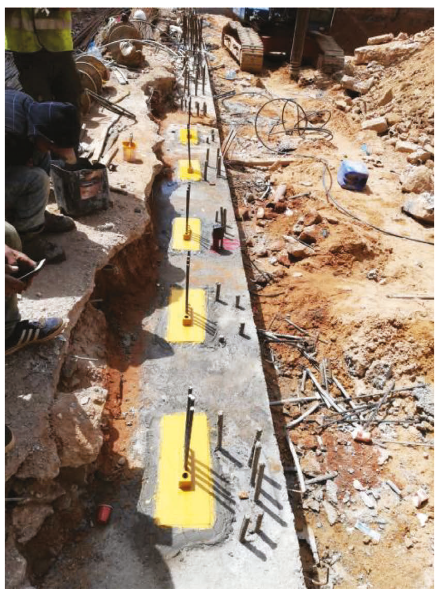
Figure 7: PTP in section 1.